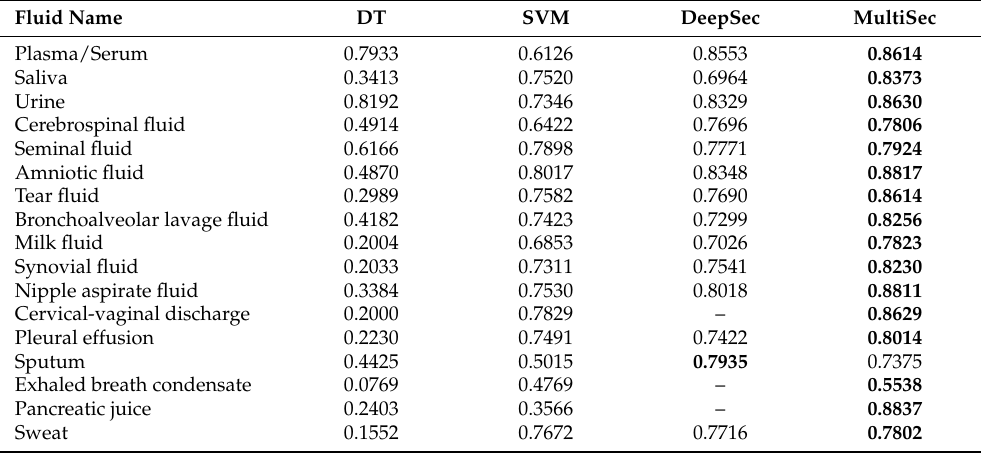
Table A2. SN benchmarks of MultiSec and compared methods on the independent testing datasets of 17 human body